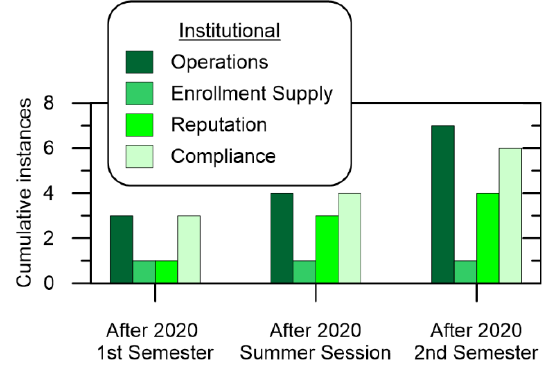
Figure 5. Cumulative Institutional impact over time.